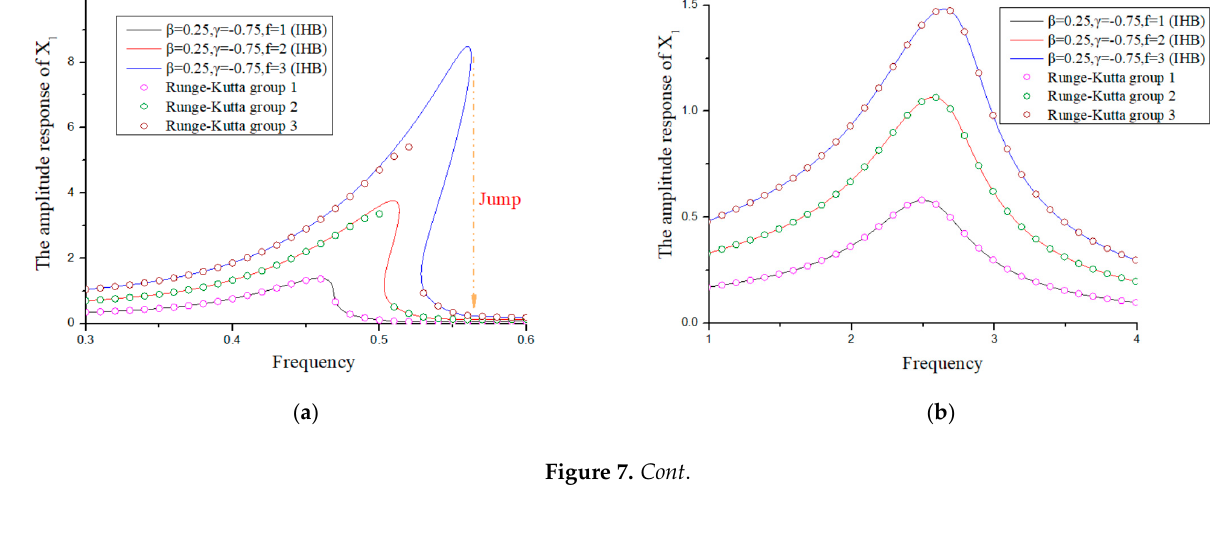
( f ) Figure 7. Amplitude – frequency characteristic curve of the isolation structure under different excitation amplitudes (when =0.25 = 0.75 β γ − ， ) ( a , b ) Amplitude – frequency characteristic curve of the substructure; ( c , d ) Amplitude – frequency characteristic curve of the superstructure; ( e , f ) Amplitude – frequency characteristic curve of the hysteretic element.